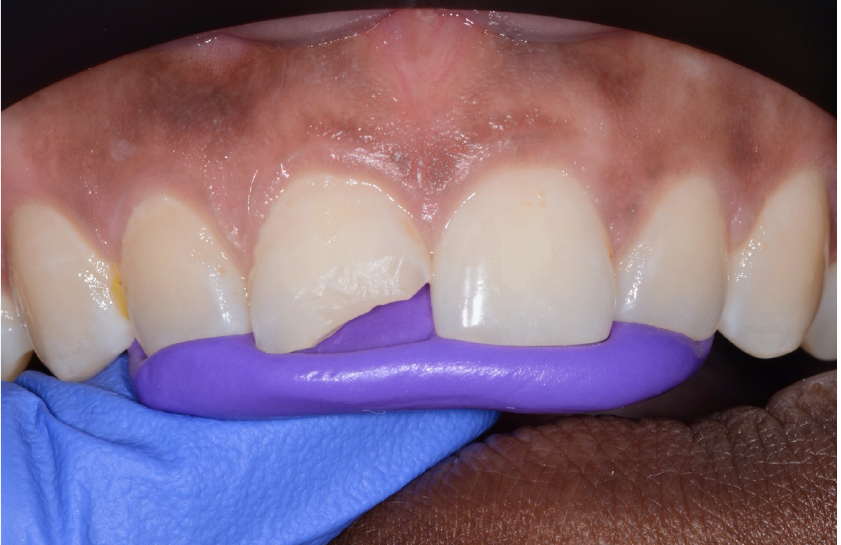
Figure 4. Fitting of the layering key after production of an enamel bevel in tooth 11. (©Max Diekamp).